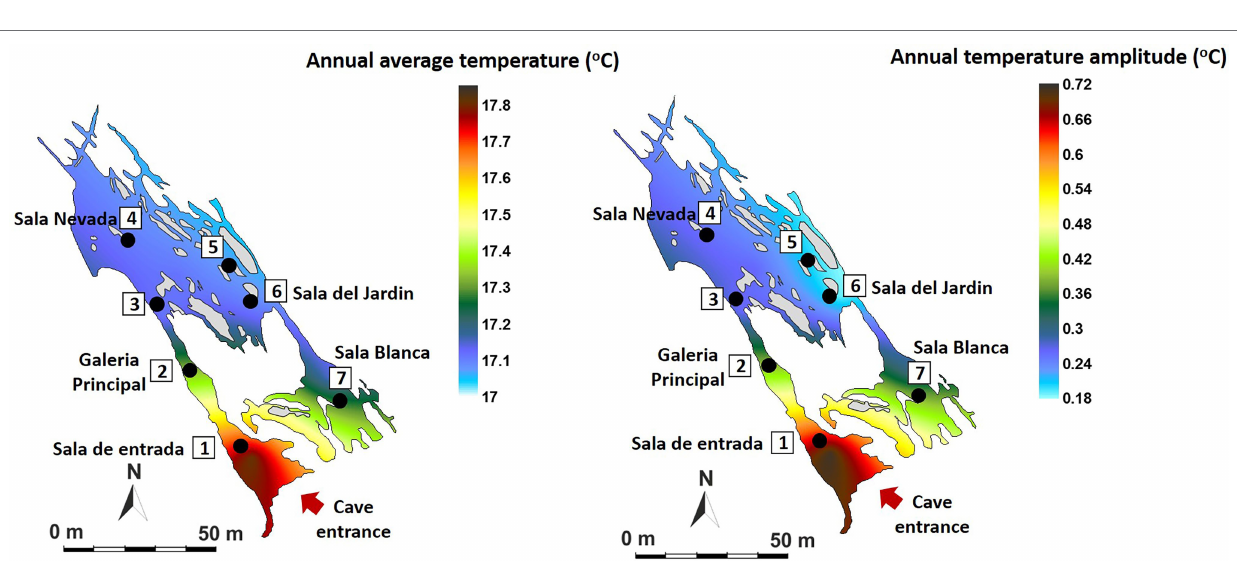
FIGURE 3 | Spatial distribution in Castañar Cave of mean annual air temperature and maximum amplitude of annual variation expressed in degrees centigrade ( °